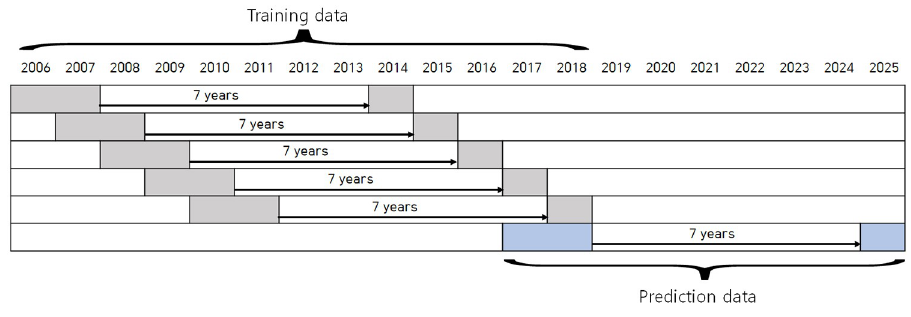
Fig 2. Construction of training and prediction